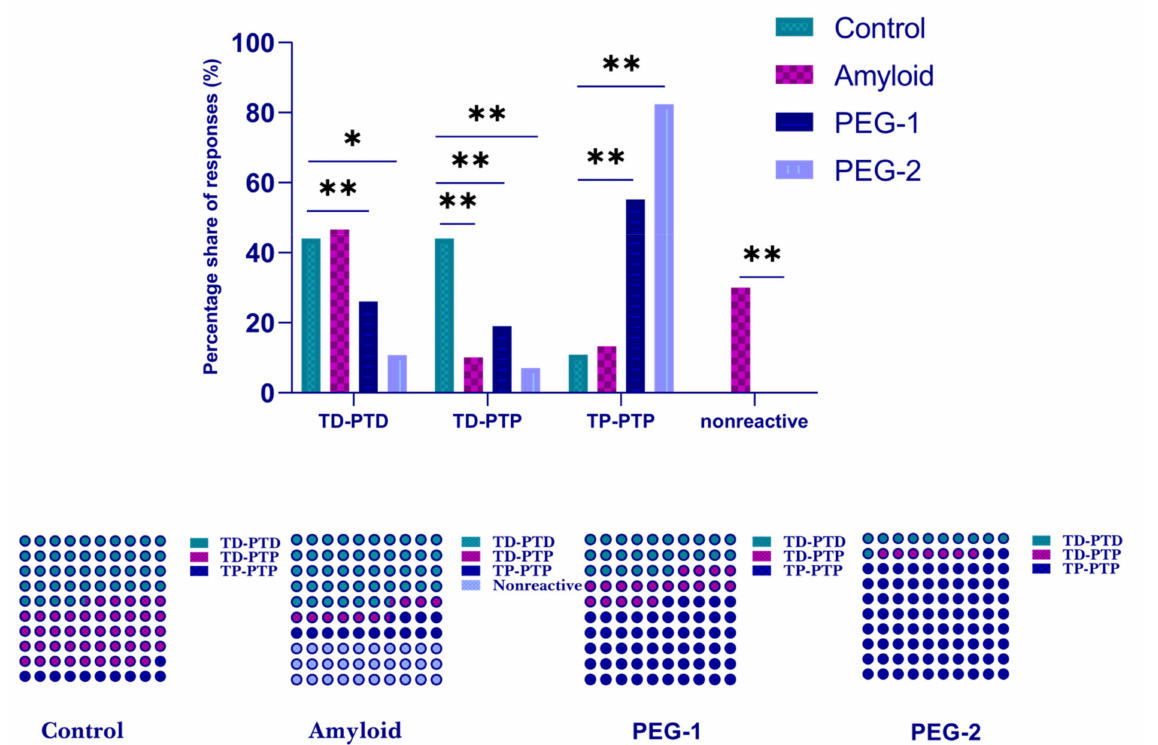
Figure 6. Percentage distribution of responses of hippocampal neurons to HFS of EC at neurodegeneration and under the influence of PEG. Percentage distribution for specified types of responses (TD-PTD, TP-PTP, TD-PTP and nonreactive) in experimental groups control ( n = 6 rats), amyloid ( n = 5 rats), PEG-1 ( n = 5 rats) and PEG-2 ( n = 5 rats). The statistical significance was estimated according to the chi square test. (* p < 0.05, ** p <